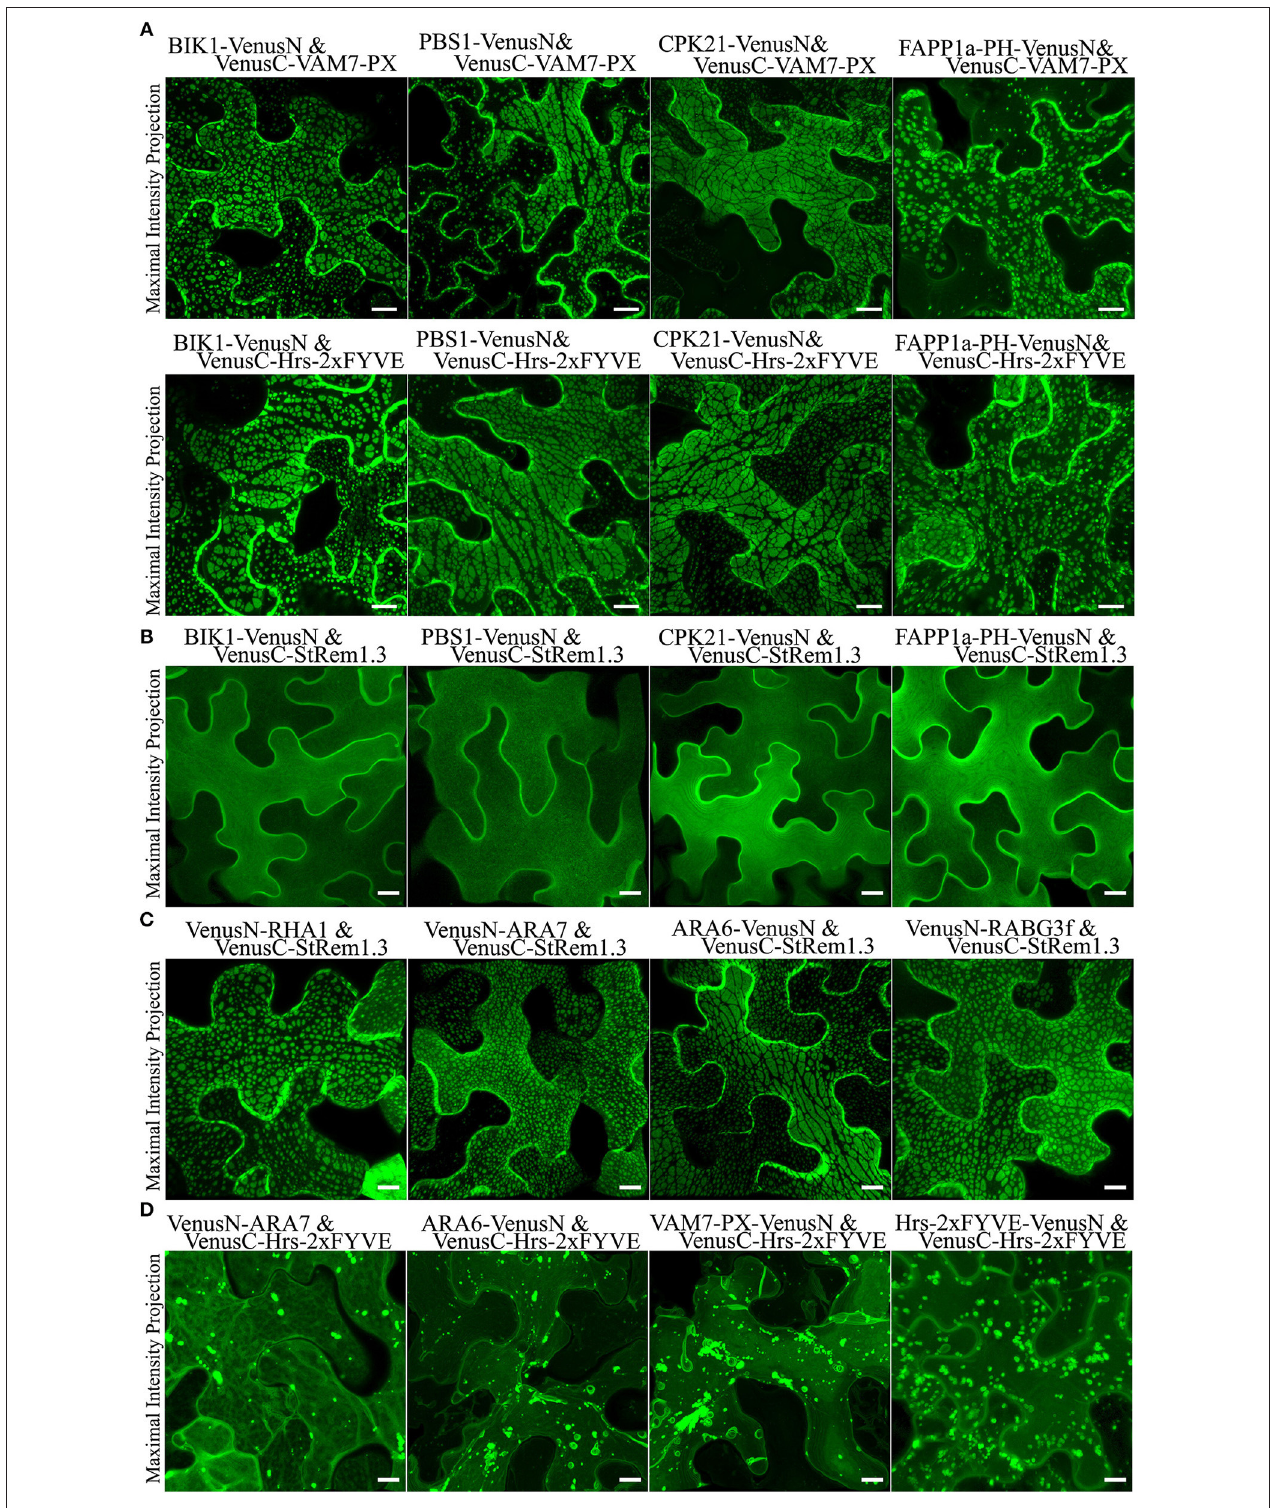
FIGURE 2 | Membrane patches can be formed in N. benthamiana leaf cortical cells only by BiFC complexes containing a protein targeted to the PM and a protein targeted to multi-vesicular bodies (MVBs) and the tonoplast. (A) Peripheral membrane proteins BIK1, PBS1, CPK21, or PtdIns(4)P-binding protein FAPP1a fused to VenusN could produce membrane patches when co-expressed in BiFC complexes with VenusC-VAM7-PX or VenusC-Hrs-2xFYVE. (B) Fluorescence distribution of